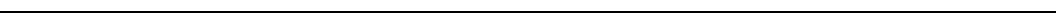
Fig. 5 Na v 1.2-mediated Na + currents underlie the excitability of pre-OLs and allow generation of APs. a Representative traces of voltage-activated inward and outward Na v -mediated currents in response to step-voltage commands ( − 80 to 40 mV, holding at − 80 mV) in excitable pre-OLs (P9) in control conditions ( left ), in the presence of 2 mM 4-AP and 10 mM TEA ( middle ), and with addition of 1 µ M TTX ( right ). Arrows indicate peak outward currents (I peak ), steady-state outward currents (I steady ), and inward currents. The TTX-sensitive current was obtained by subtracting the inward current in the 4-AP +TEA condition from that in the TTX condition. b I Na in excitable pre-OLs in response to step-voltage commands (as in a ) in the presence of 2 mM 4-AP, 10 mM TEA, and 0.2 mM CdCl 2 and with a Cs-based internal solution. µ -Conotoxin KIIIA (1 µ M; Na v 1.2 channel inhibitor) completely inhibited I Na . bottom Expanded time scale for the inward currents at 0 mV. c Representative traces of µ -conotoxin KIIIA – sensitive I Na at − 30, − 20, − 10 and 0 mV top to bottom . d Current – voltage relationship of I Na in control conditions ( black ) and in the presence of µ -conotoxin KIIIA ( gray ). e Mean voltage dependence of activation and inactivation for I Na . Inactivation and activation kinetics of Na v in pre-OLs were examined by a series of 200-ms prepulses ( − 100 to − 10 mV) followed by a 10-ms test pulse at 0 mV. V a and V h indicate the half-activation and half-inactivation potentials, respectively, of Na v in pre-OLs. Data represent the mean ± s.e.m. f Voltage-activated K + and Na + currents in response to step depolarization ( − 60 mV to 30 mV) in excitable pre-OLs in voltage-clamp recordings (P12). Pre-OLs displayed APs in response to current injections (60 – 140 pA). In the same cells, µ -conotoxin KIIIA (1 µ M) completely inhibited AP fi ring. Inset, magni fi ed traces of APs. g A single AP evoked by a brief current injection (500 pA, 1.8 ms) in control conditions ( black ) and in the presence of µ -conotoxin KIIIA (1 µ M, red ). h Post-recording immunostaining for CNPase ( cyan ) and Na v 1.2 ( green ) in the same cell as f loaded with Alexa 568 ( red ). Arrows indicate a pre-OL that displayed I Na and APs during whole-cell recording. Asterisks indicate MNTB principal neurons (diameter > 20 µ m). Scale bar